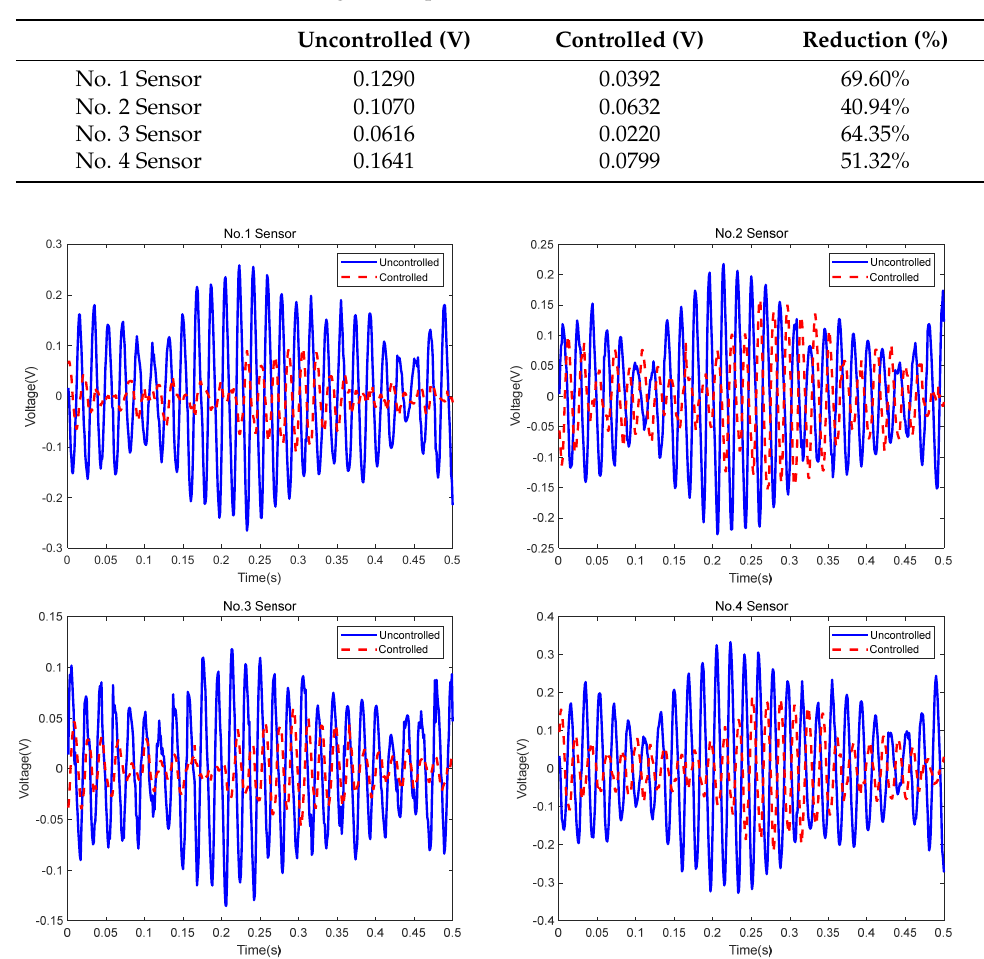
Figure 15. Actuator control signals obtained by experiments (1 V represents 12.3 N). Table 5. RMS values of sensor signals: Experiment #2.